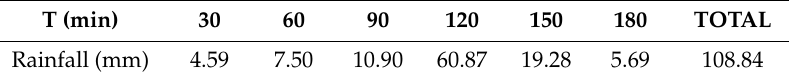
Table 2. Design storm of the proposed hydrological